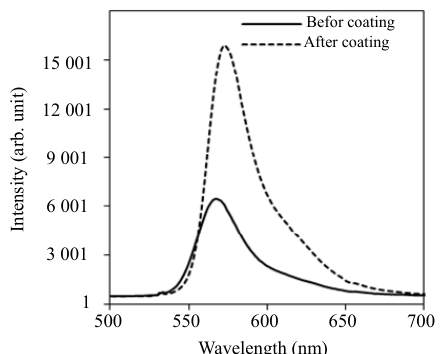
Fig. 7 Laser-induced fluorescence of RB dye before and after the deposition of nanostructured SiO 2 thin films on two sides of the dye